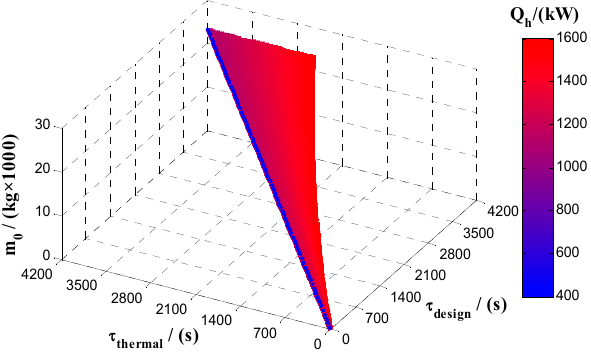
Figure 3. Influence of m 0 and τ design on τ thermal under different values of Q h .